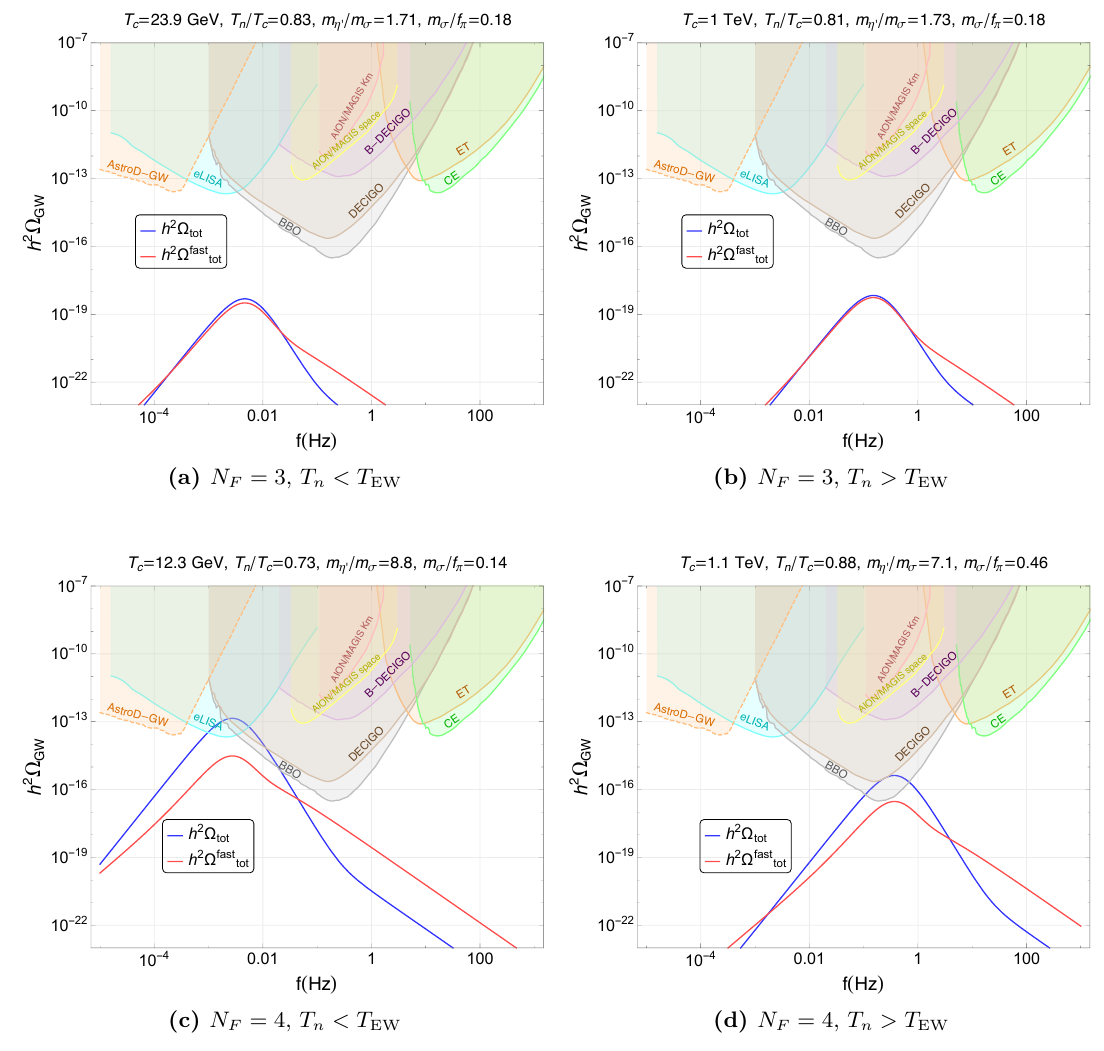
Figure 5. Same as in figure 4 but for the non QCD-like case defined in section 4.3. The parameters of the benchmarks shown are collected in table